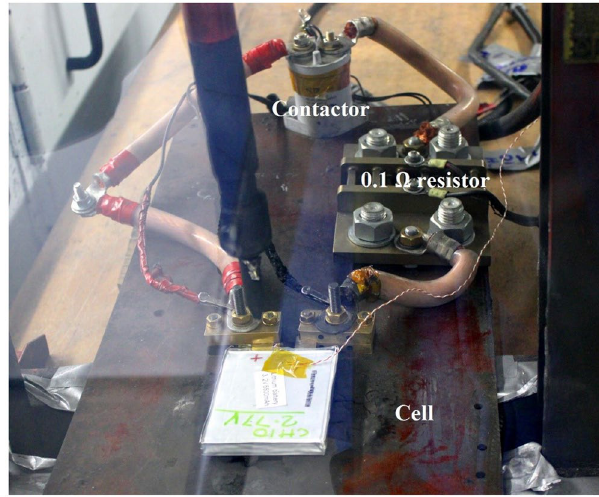
Figure 4. External short circuit test